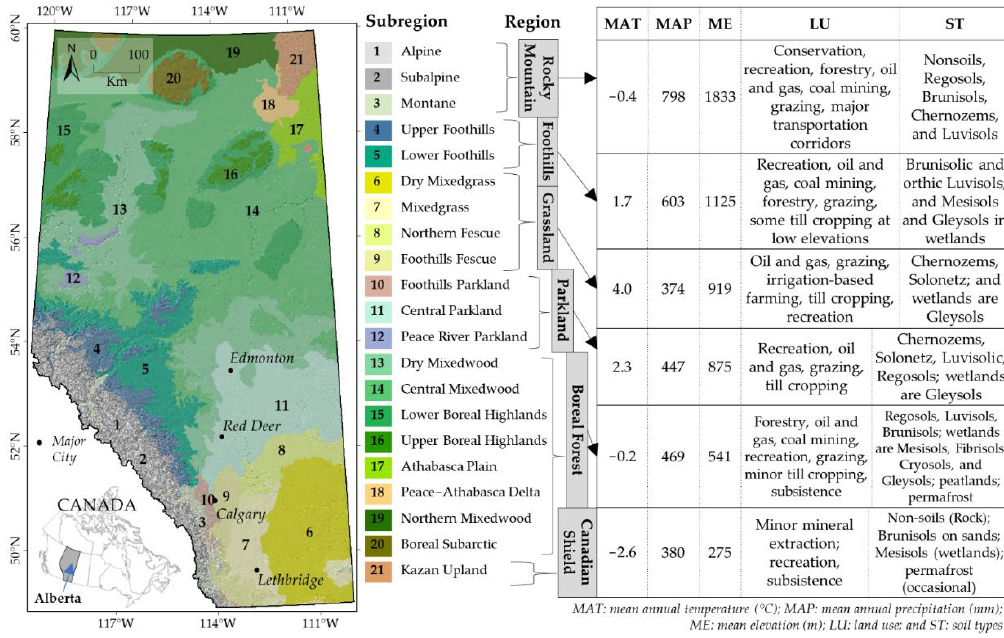
Figure 1. Study area map showing the 21 natural subregions of Alberta and their characteristics.